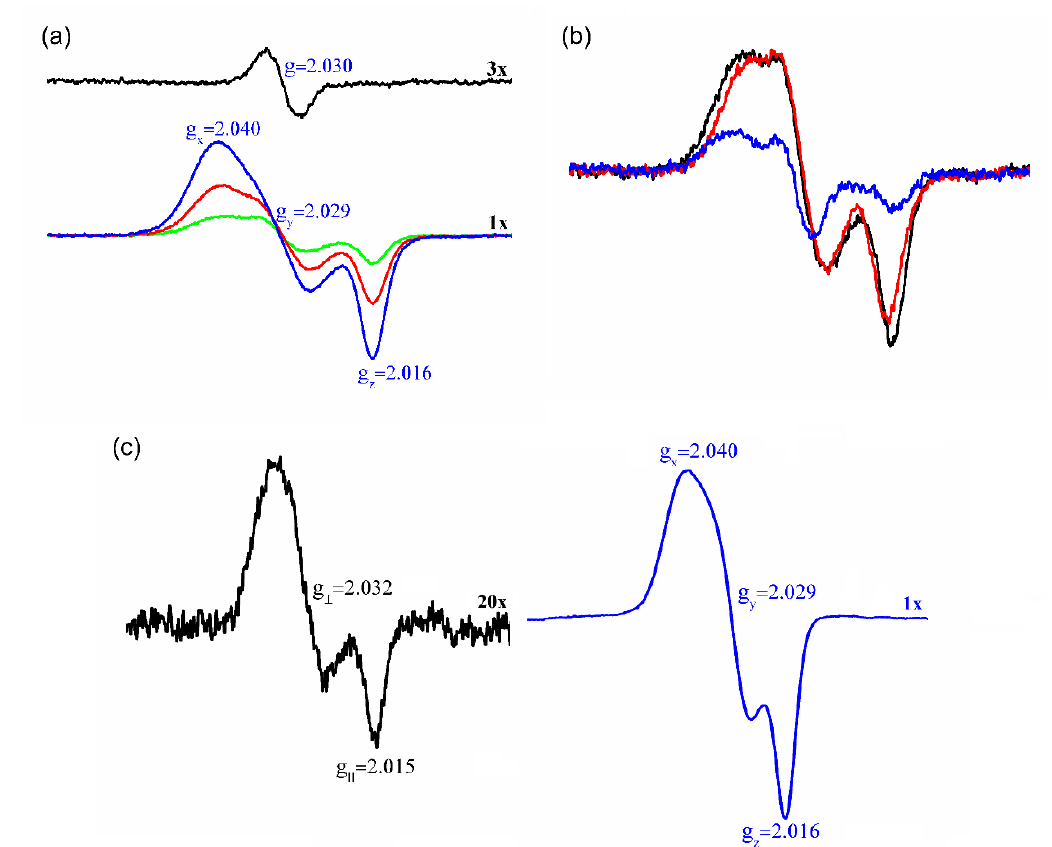
Figure 5. EPR detection of dinitrosyl-iron complex (DNIC)-Prx1 complexes. ( a ) Representative EPR spectra of DNIC-GS (60 µ M) before (black trace) and 30 min after addition of 30 (green trace), 60 (red trace) or 120 µ M (blue trace) Prx1 scanned at room temperature. ( b ) Representative EPR spectra of DNIC-GS (60 µ M) 30 min after addition of 30 µ M of wild-type Prx1 (black trace), Prx1C83SC173S (red trace) or Prx1C52S (blue trace) scanned at room temperature. ( c ) Time-dependent 77K EPR spectrum of DNIC-GS (60 µ M) plus Prx1 (60 µ M) after 2 (black trace) or 30 min (blue trace) incubation. Aliquots of the incubation were removed at the specified times and frozen to stop the interaction and the EPR spectrum acquired at 77 K. All the incubations were performed in phosphate buffer (50 mM) containing DTPA (0.1 mM), pH 7.4 (final) at 25 °C.